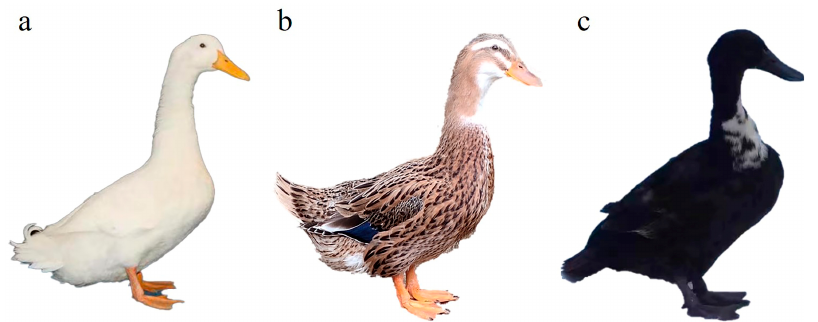
Figure 1. Representative images of color in duck plumage. ( a ) Duck with white plumage (Peking duck). ( b ) Duck with spotty plumage (Shanma duck). ( c ) Duck with black plumage (Wendeng black duck).